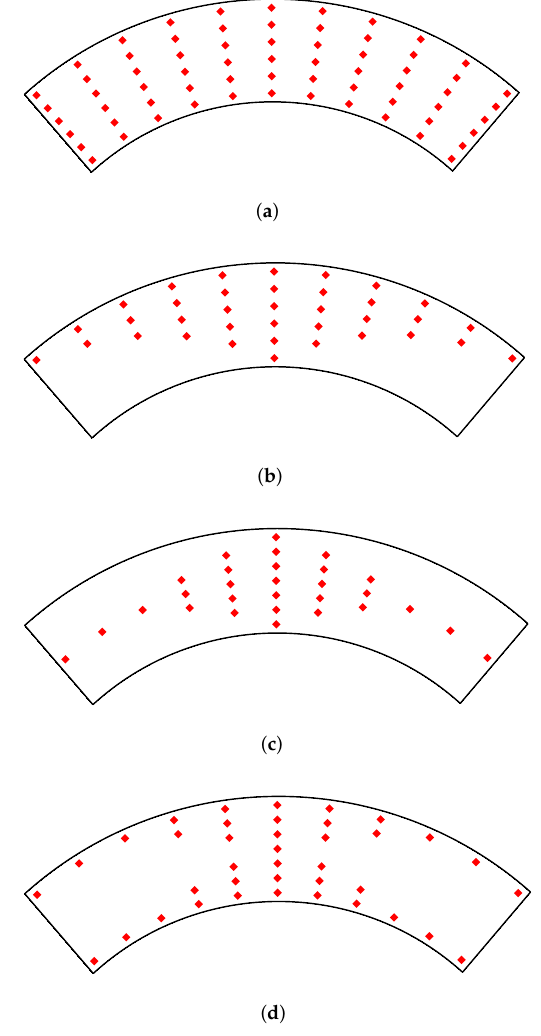
Figure 2. CNT distributions for FG-CNTRC membrane structure. ( a ) UD, ( b ) FG-V, ( c ) FG-O, ( d )